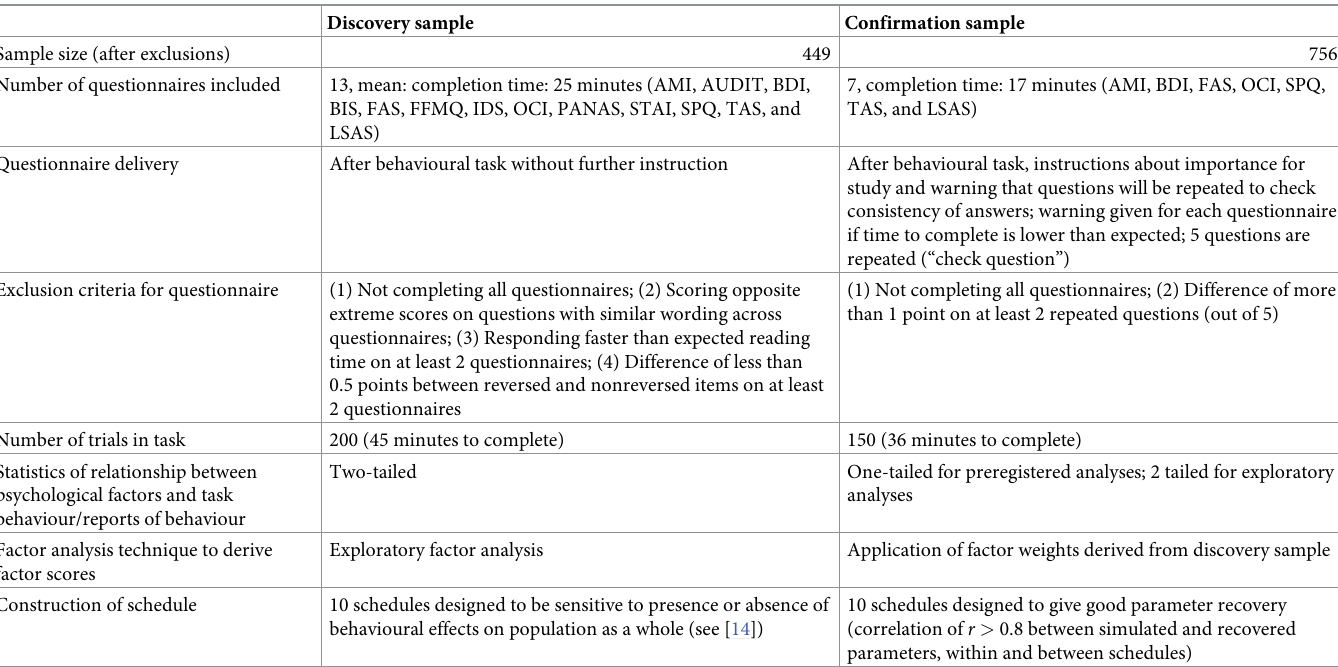
Table 5. Differences between the discovery and confirmation